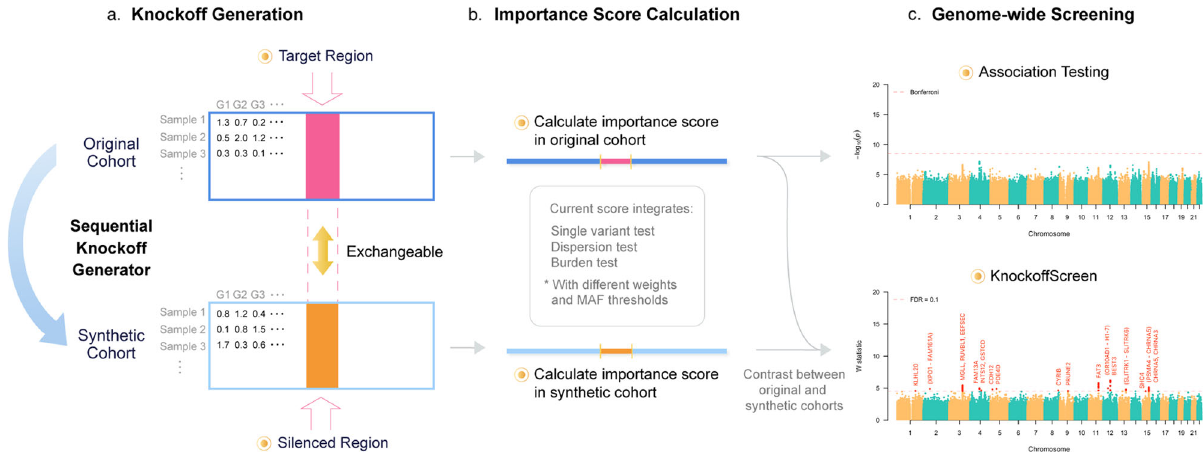
Fig. 1 Overview of KnockoffScreen. a Knockoff generation based on the original genotype matrix. Each row in the matrix corresponds to an individual and each column corresponds to a genetic variant. Each cell presents the genotype value/dosage. b Calculation of the importance score for each 1 bp, 1 kb, 5 kb, or 10 kb window. c Example of genome-wide screening results using conventional association testing (top) and KnockoffScreen